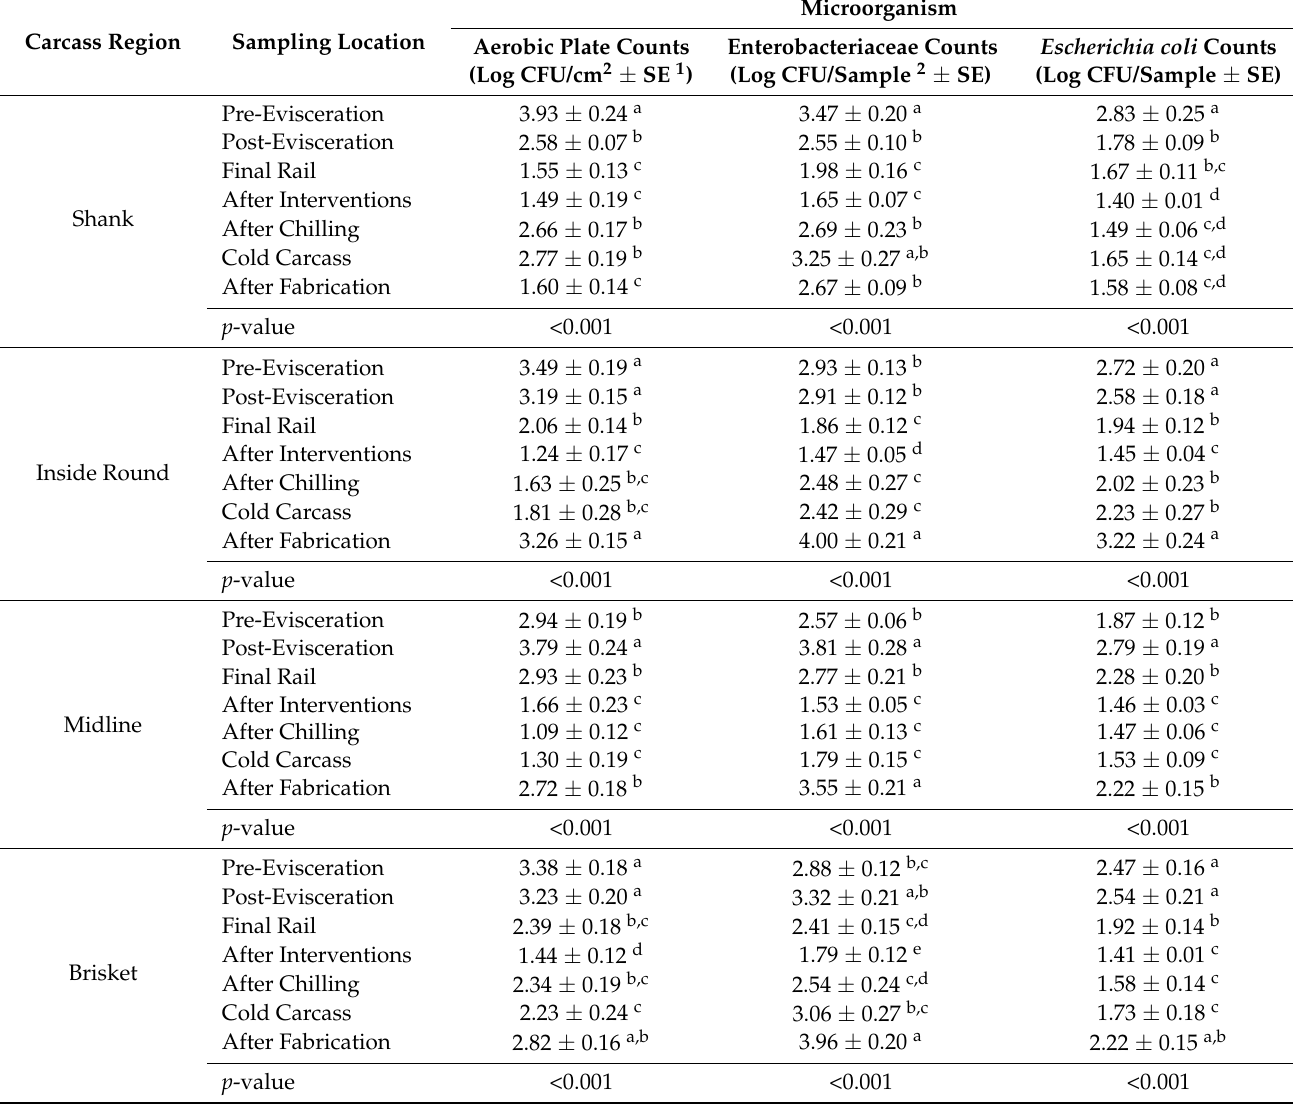
Table 1. Summary table of indicator counts for all carcass regions at each sampling location through- out the beef processing line (n = 24 carcass region/sampling